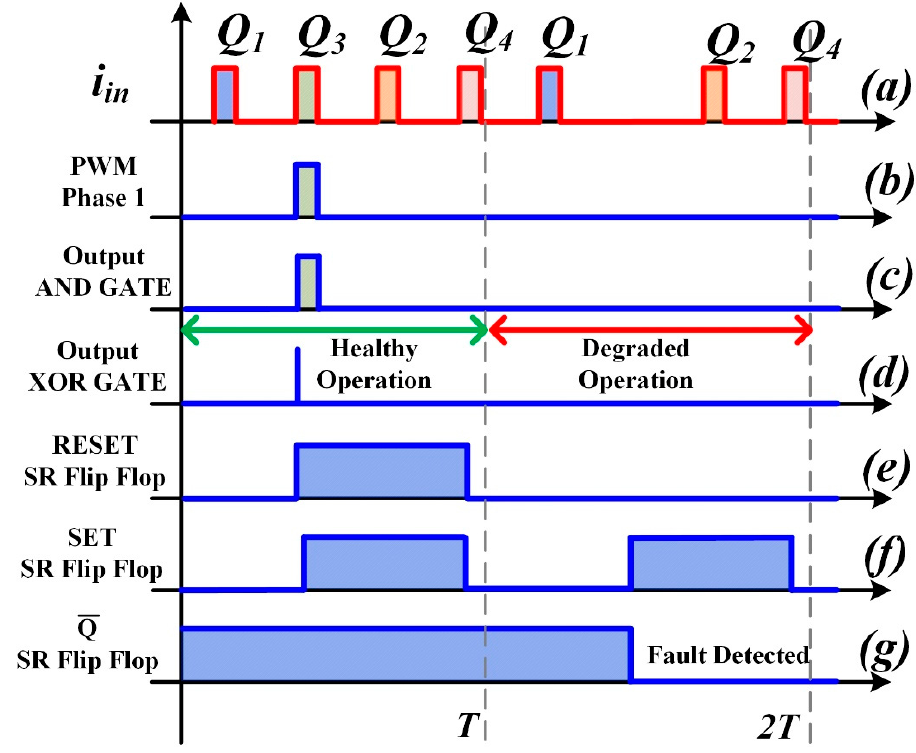
Figure 6. The diagram of proposed fault diagnosis method in case of an OCF in phase 3.